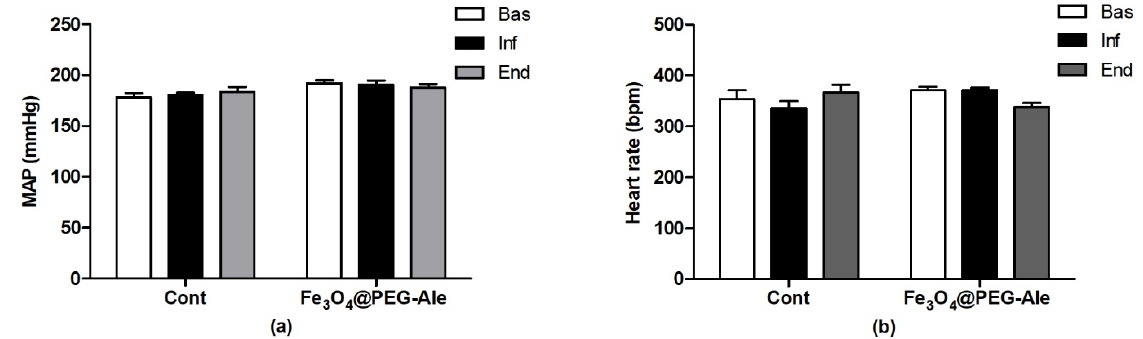
Figure 5. ( a ) Mean arterial pressure and ( b ) heart rate of rats 10–14 min before infusion, during infusion, and 100 min after infusion of nanoparticles. The values represent the mean ± SEM, n = 6–7 per group. Fe 3 O 4 @PEG-Ale, Fe 3 O 4 @PEG- alendronate nanoparticles; MAP, mean arterial pressure; HR, heart rate; Bas, basal value; Inf, value determined during infusion; End, value at the end of the experiment; bpm, beats per minute.